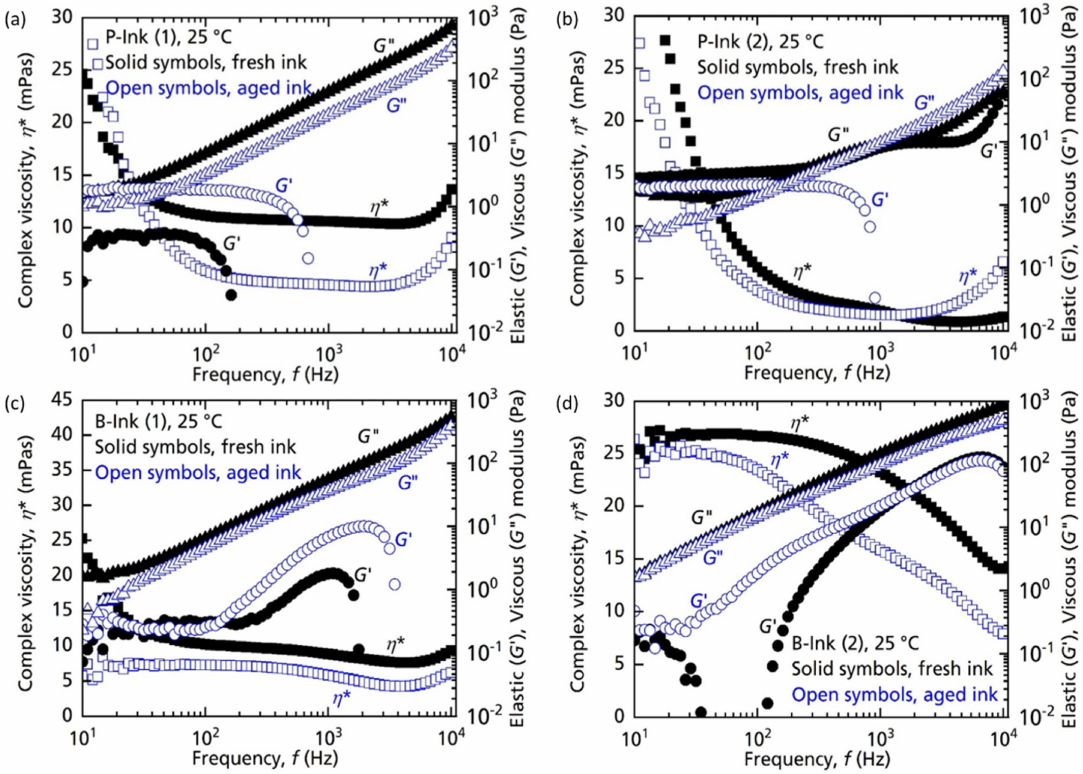
Figure 12. Rheological flow curves exhibiting aging effects. Complex viscosity ( η * ), elastic ( G (cid:48) ) and viscous ( G ”) modulus measurements of ( a ) P-ink (1), ( b ) P-ink (2), ( c ) B-ink (1) and ( d ) B-ink (2) with respect to frequency ( f ) at 25 ◦ C utilizing the PAV